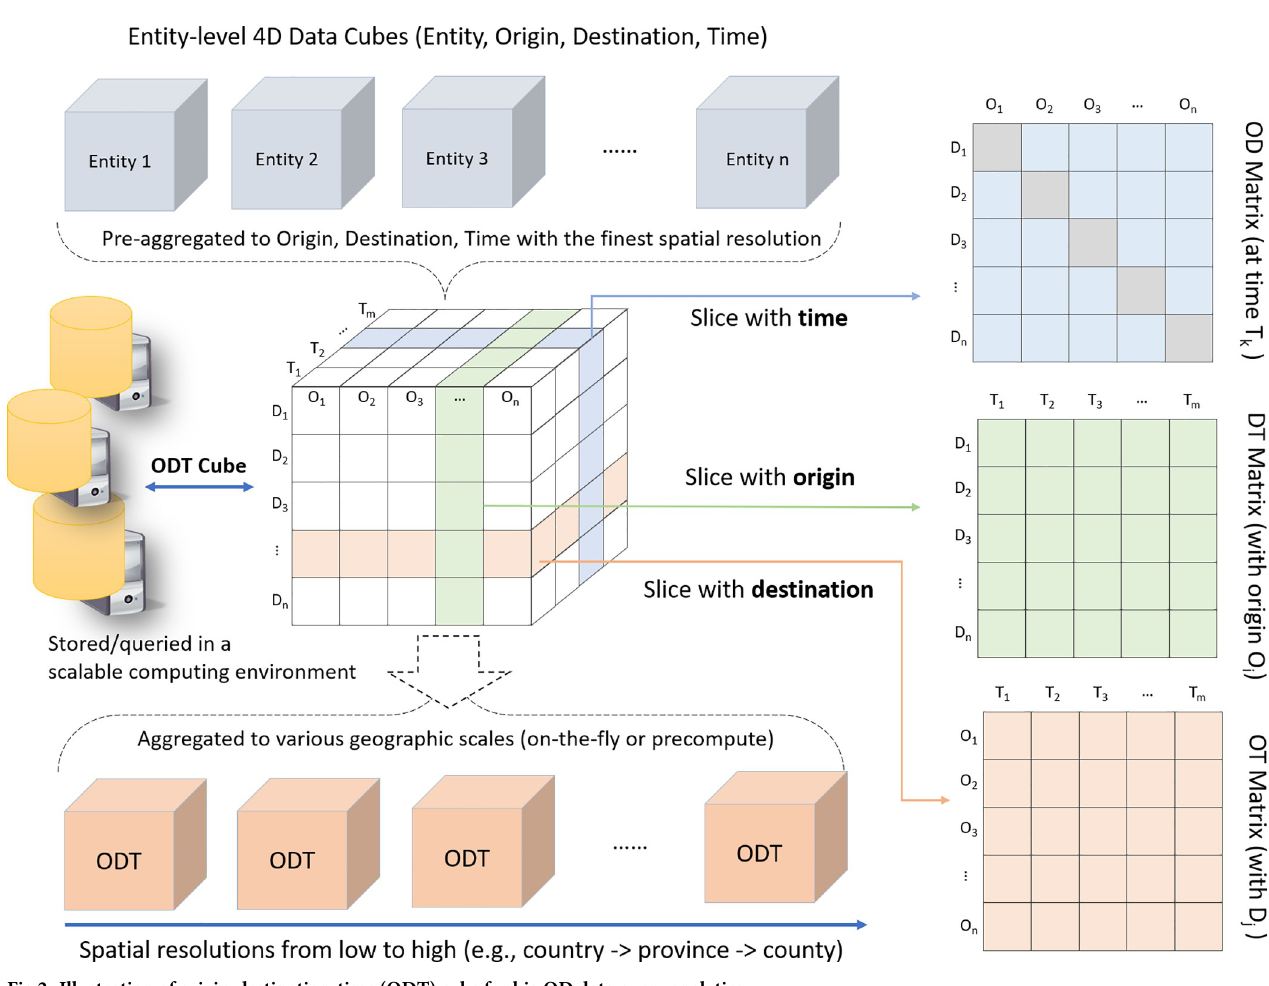
Fig 2. Illustration of origin-destination-time (ODT) cube for big OD data query analytics.